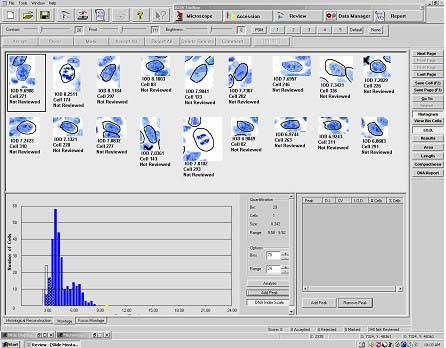
ACIS screen showing montage of microscopically selected and operator edited Feulgen-stained nuclei and the DNA content histogram generated on the basis of integrated optical density.